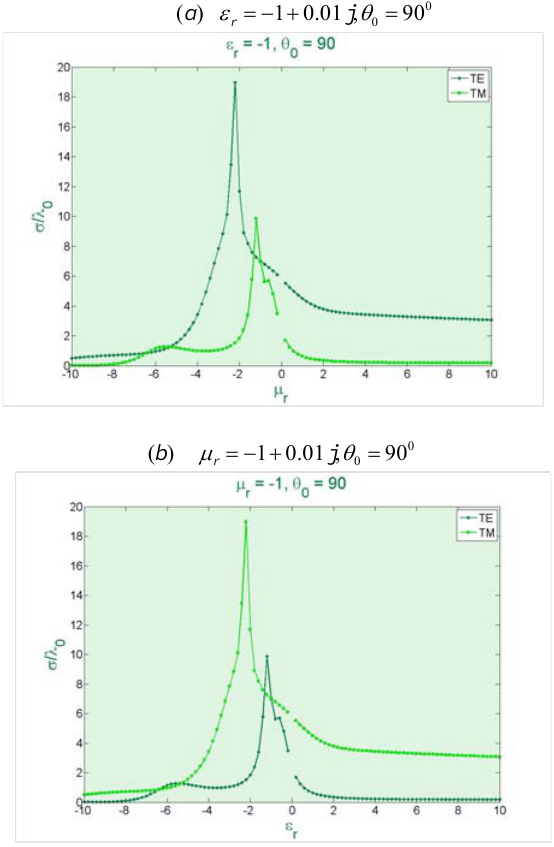
Figure 6: Normalized monostatic echo width of Metamaterial cylinder (a=5mm, f=1GHz) for resonance condition or RCS maximization.